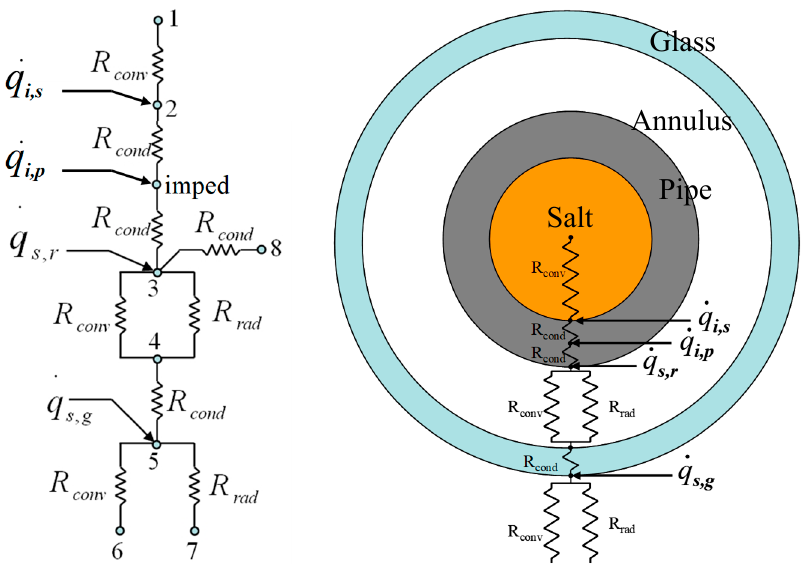
Figure 8. Updated thermal resistance network for the heat collection element (HCE) thermal losses model. q · i,p = impedance heat generation at thermodynamic centre of pipe wall. q · i,s = impedance heat generation in salt.